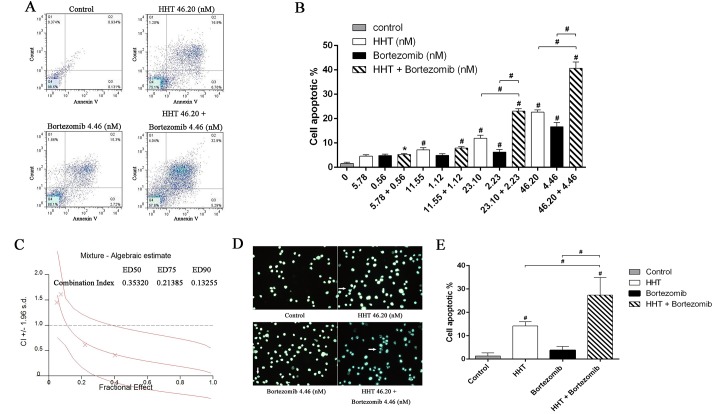
HHT and Bortezomib synergistically induced apoptosis of SKM-1 cells.(A) Annexin V/PI double-staining flow cytometry of SKM-1 cells treated with 46.20 nM HHT, 4.46 nM Bortezomib and simultaneous treatment experiments at molar ratio of 10.4: 1. (B) The proportion of apoptotic cells in a histogram. (C) CI values for HHT and Bortezomib combination treatments at the molar ratio of 10.4:1. (D) Cell apoptosis assessed by florescence microscopy (magnification 400×). The arrows indicate the cells undergoing apoptosis. (E) The percent of apoptotic cells determined by morphology-based cell sorting. *P < 0.05, #P < 0.01 vs untreated control.